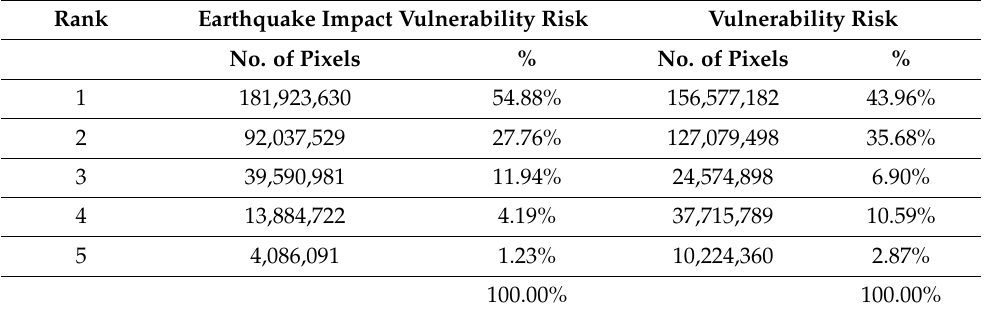
Table 1. Calculated areas of risk categories.